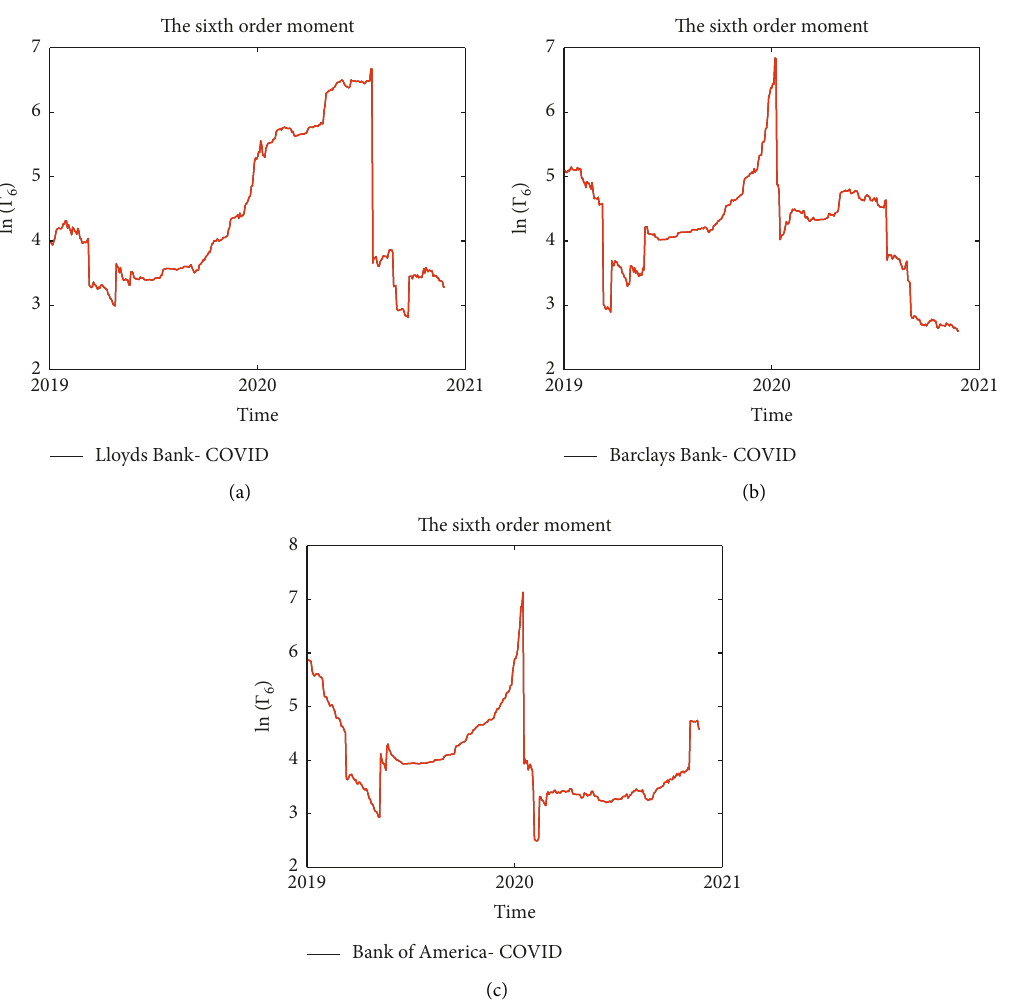
Figure 11: The time evolution for the sixth-order standardised moments for the period 2019–2021, the COVID-19 pandemic. In panel (a), we show the analysis for Lloyds Bank, (b) details the same for Barclays Bank, and finally (c) shows the Bank of America. In panels (b) and (c), we see the sharp increase followed by a decrease, which is the representative of an economic crisis being present, this is around the start of the pandemic. However, Lloyds Bank does not necessarily follow this and instead, we see a steady increase followed by a sharp decrease further into 2020. This could be attributed to the U.K.’s slow handling of the